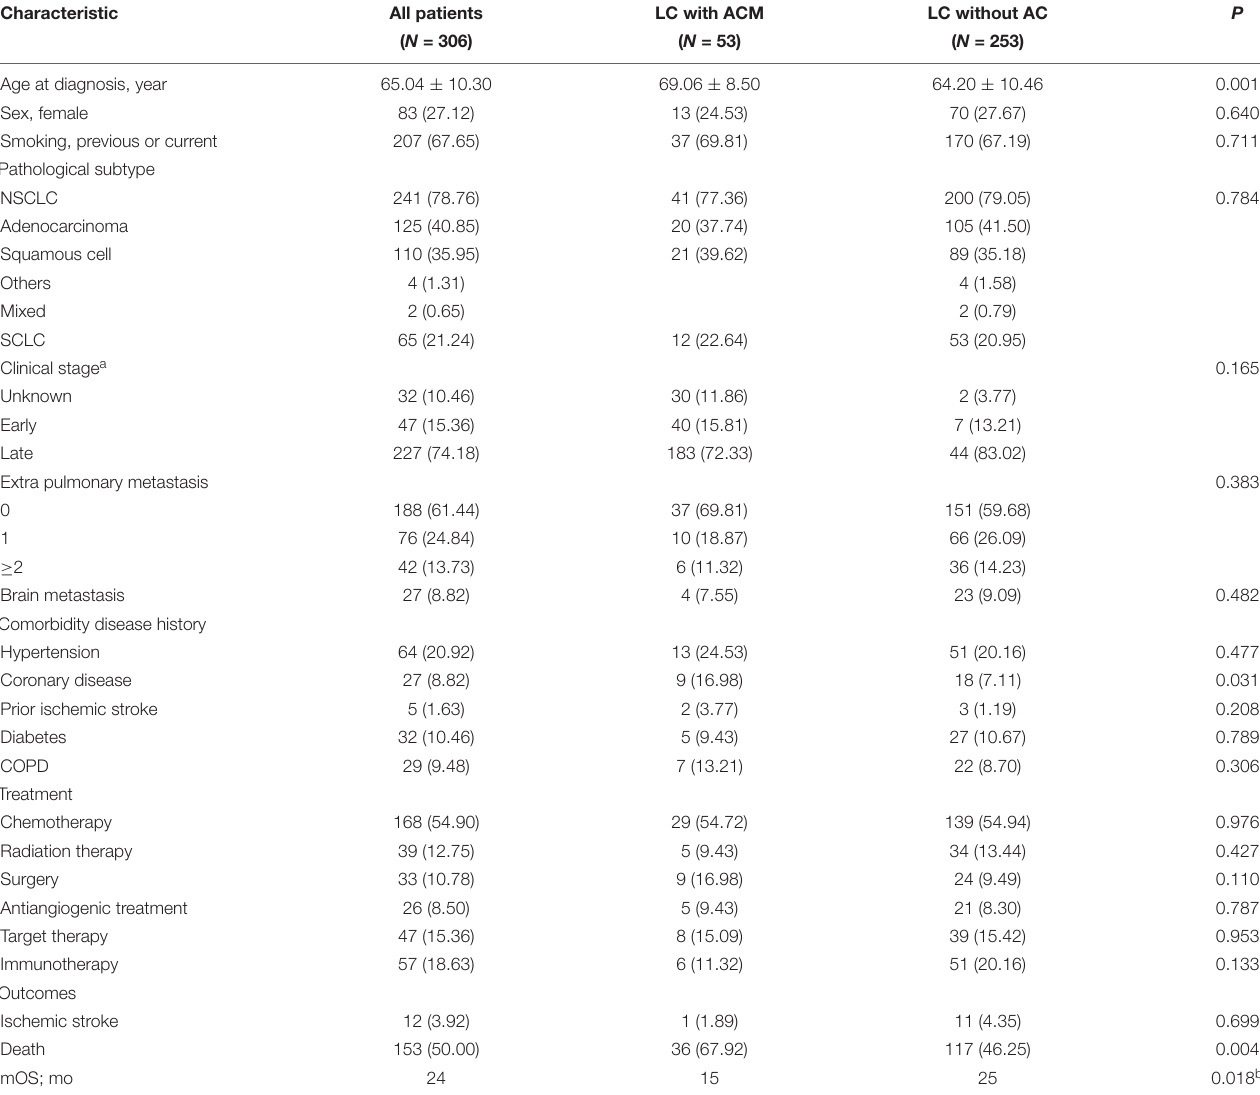
TABLE 1 | Demographic characteristics of patients with